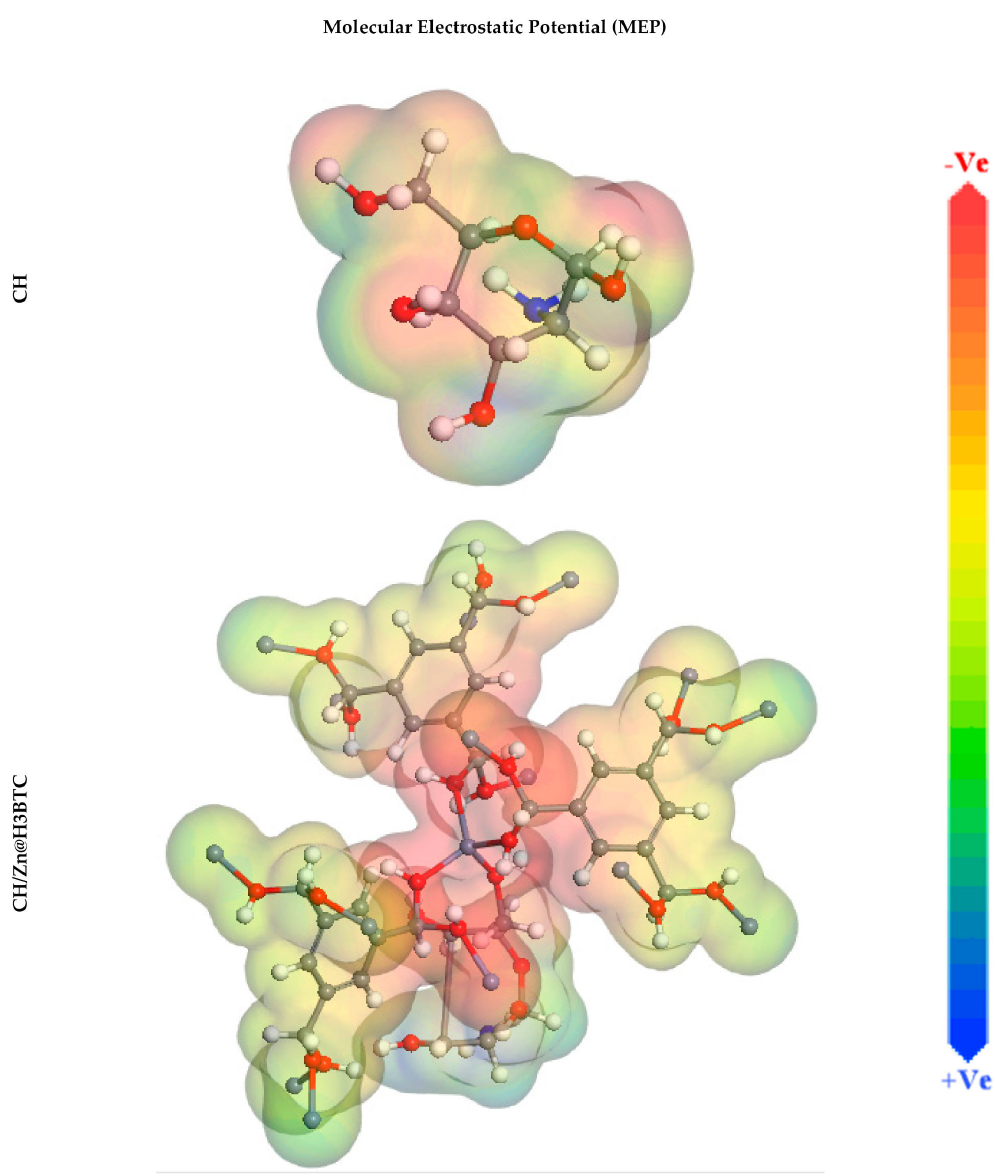
Figure 14. Graphical presentation of the MEP of the monomer structures of CH and CH/Zn@H 3 BTC created using the DMol3